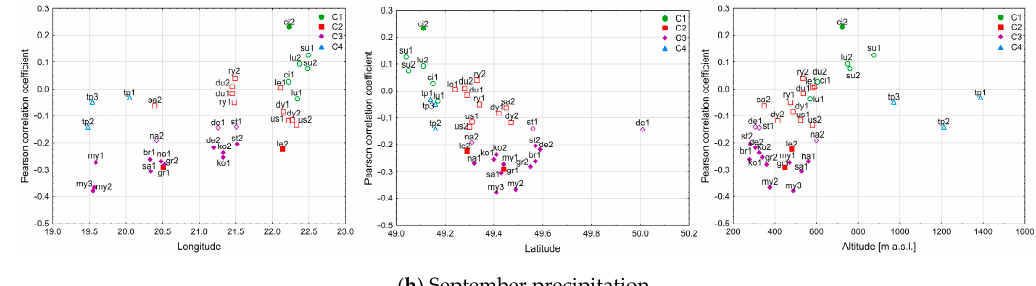
Figure 7. Results of climate–growth relationship analysis plotted against longitude, latitude, and altitude for the selected months (filled dots represent significant values).